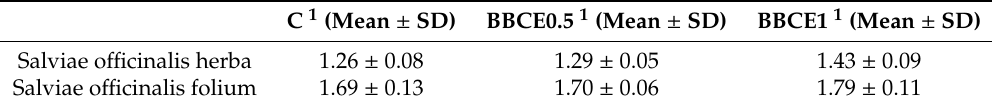
Table 4. Total volatile oil content (mL / 100 g) from sage ( Salvia o ffi cinalis L.)